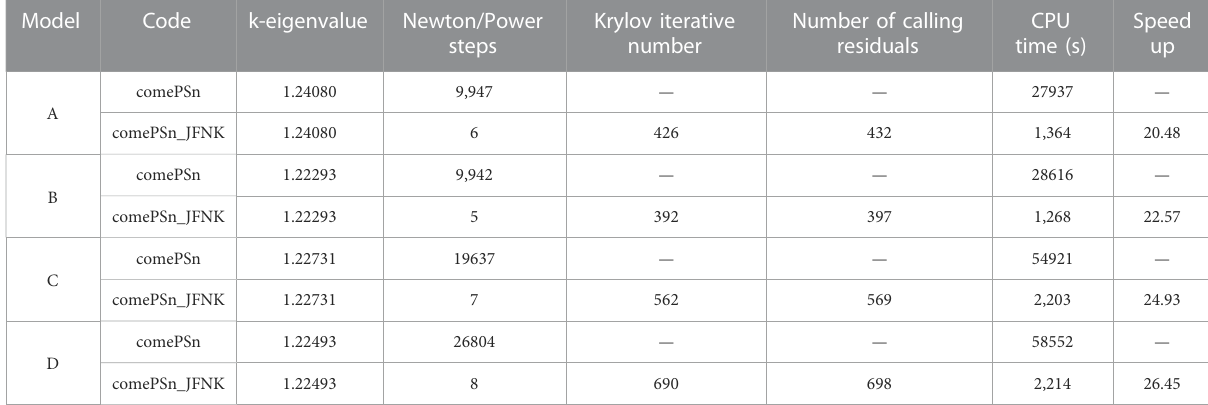
TABLE 6 Comparison of the k-eigenvalues and the computational cost for 3-D full-core MOX/UOX pin-by-pin models (1024 CPU cores).